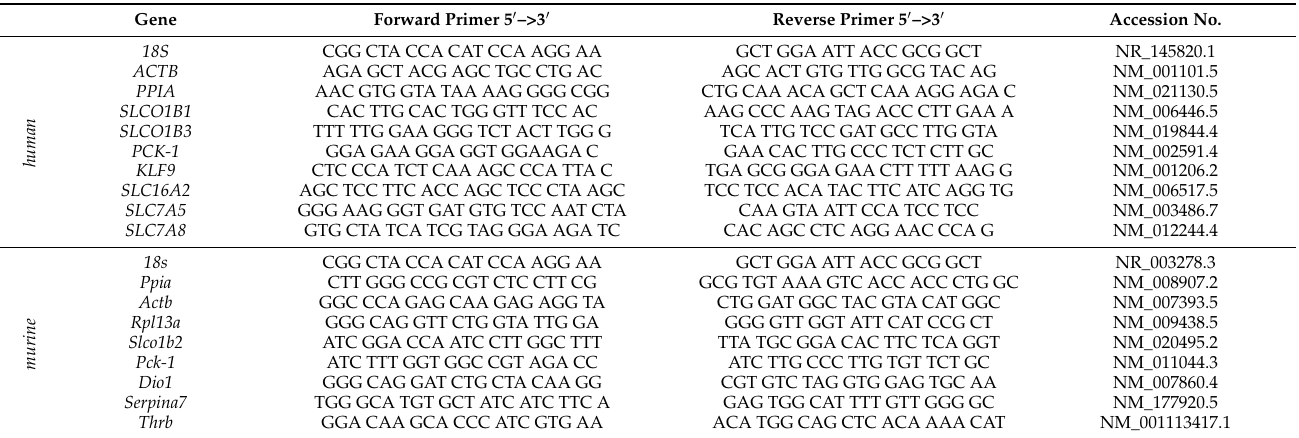
Table 2. qRT-PCR primer